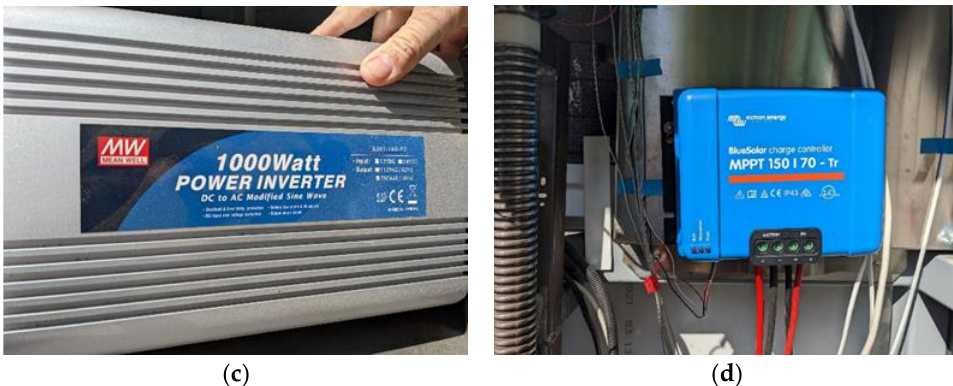
Figure 4. Photovoltaic power supply system: ( a ) PV panels, ( b ) batteries, ( c ) inverter, and ( d ) MPPT charger.